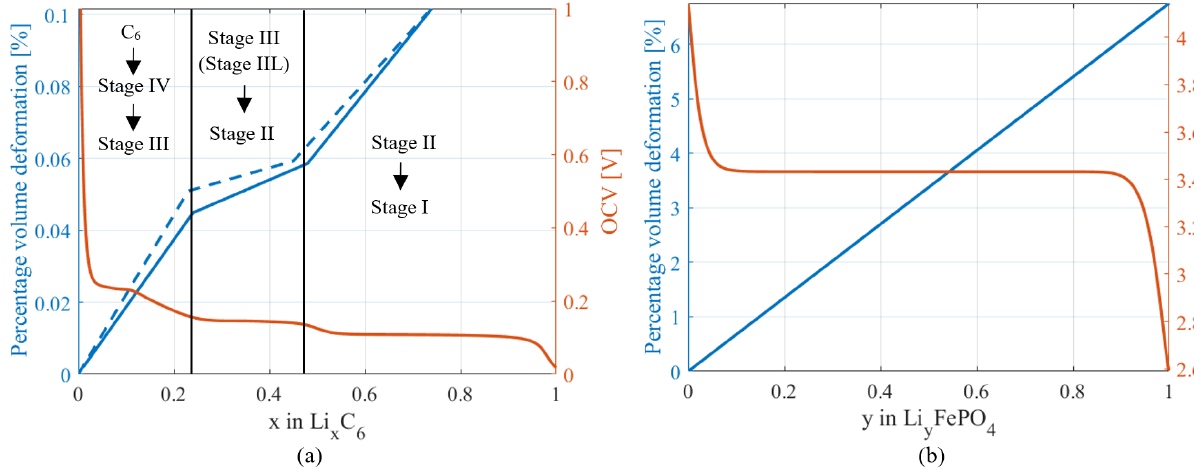
Figure 3. Blue lines refer to volume variation of crystal structure of graphite ( a ) and LFP ( b ) as a function of lithium stoichiometric index. Graphite follows a different path during lithiation (solid line) and delithiation (dashed line), as stage IIL appears just during delithiation. Red lines refer to OCV of graphite ( a ) and LFP ( b ) in